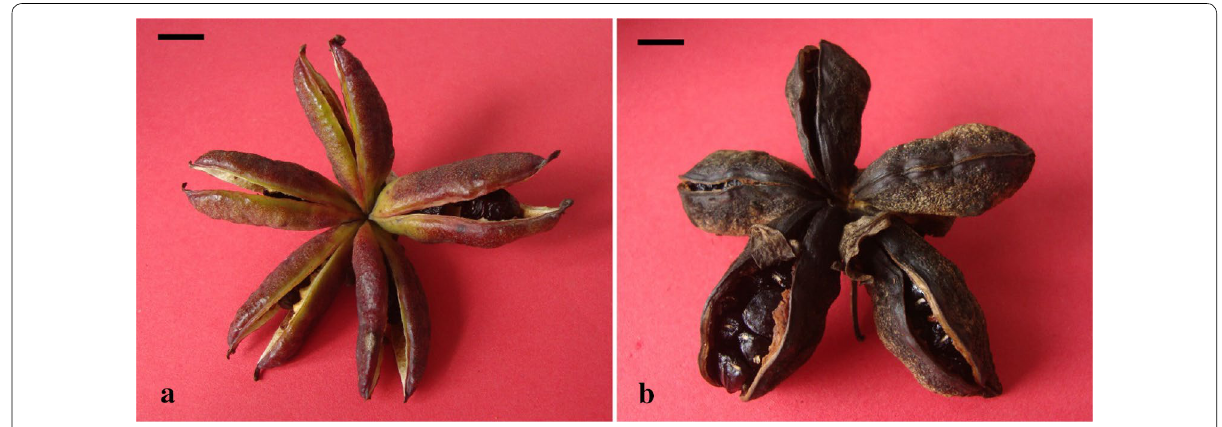
Fig. 2 Fruit and seeds. a Artificial geitonogamy; b Artificial xenogamy. Scale bar